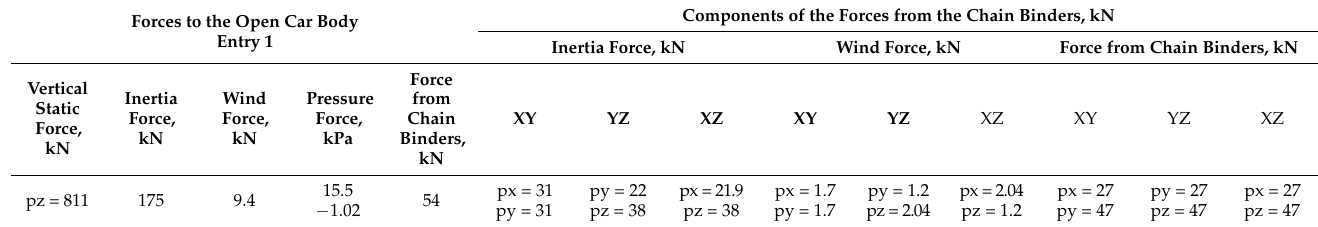
Table 1. Forces to the open car body during sea